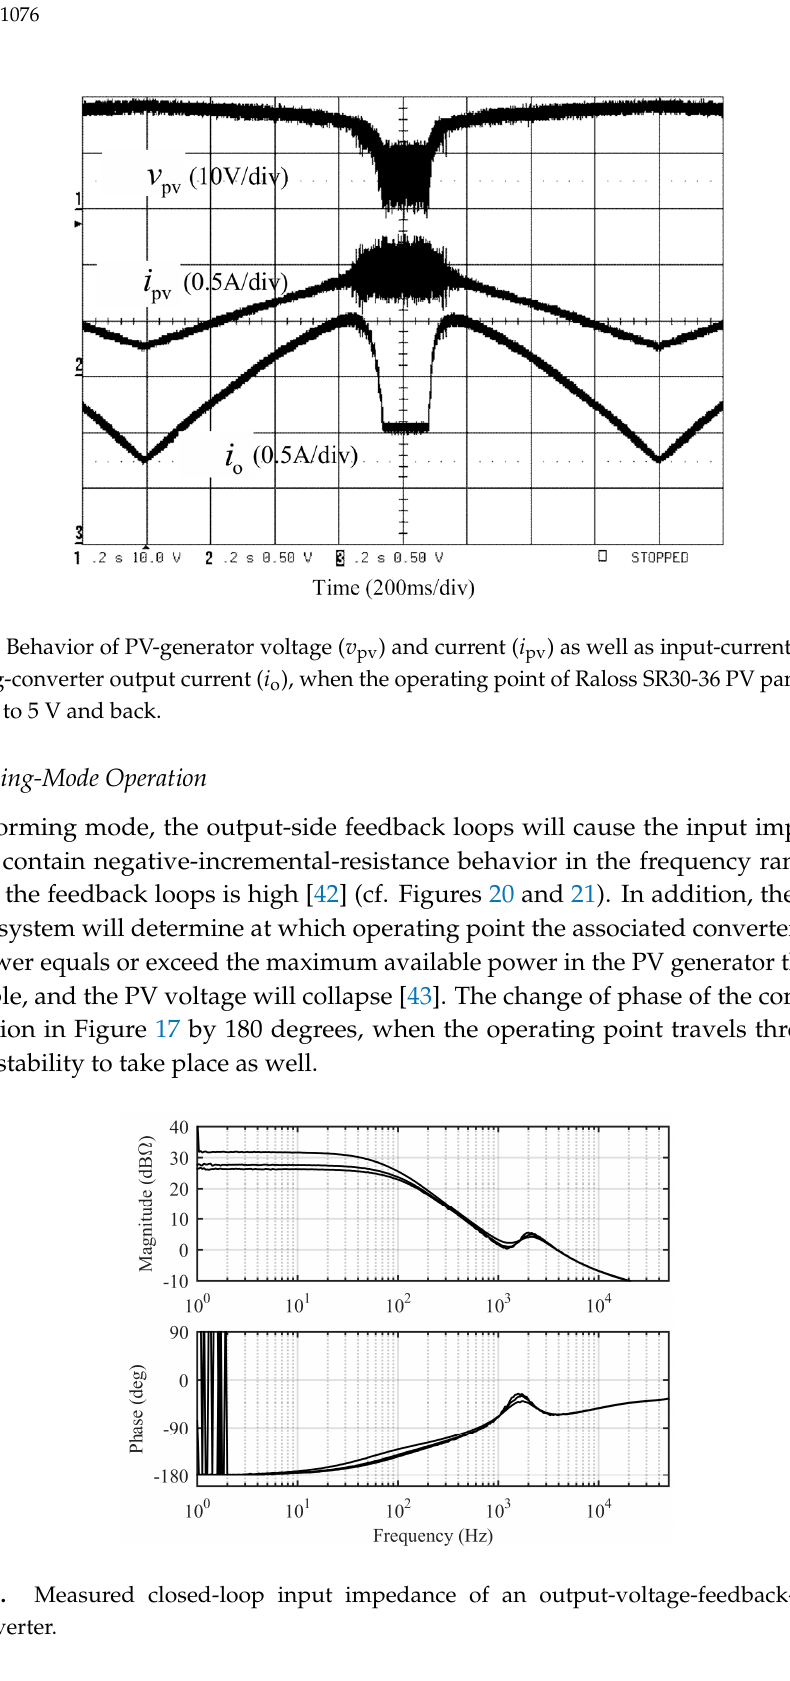
v ) and current ( i ) as well as input-voltage- pv pv i ), when the operating point of Raloss SR30-36 PV o